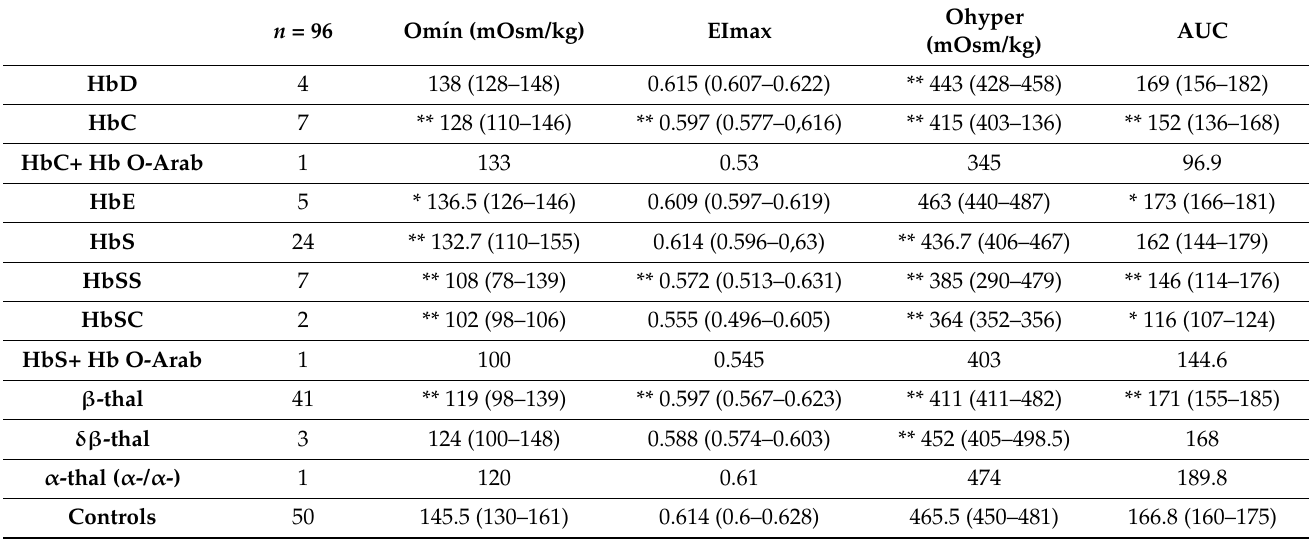
Table 2. Osmoscan parameters of the hemoglobinopathies included in this